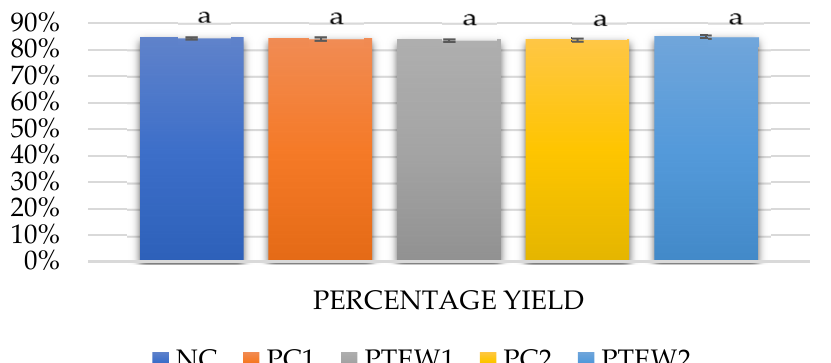
Figure 1. The effect of plasma-treated egg whites on percentage yield of liver p â t é s (mean ± SE); NC—negative control (liver p â t é s without a nitrite source); PC1—positive control (liver p â t é s with 60 ppm of sodium nitrite); PTEW1—liver p â t é s with plasma-treated egg white containing 40 ppm NO 2 − ; PC2—positive control (liver p â t é s with 120 ppm of sodium nitrite); PTEW2—liver p â t é s with plasma-treated egg white containing 80 ppm NO 2 − ; the mean values with different letters differ statistically significantly ( p < 0.05).